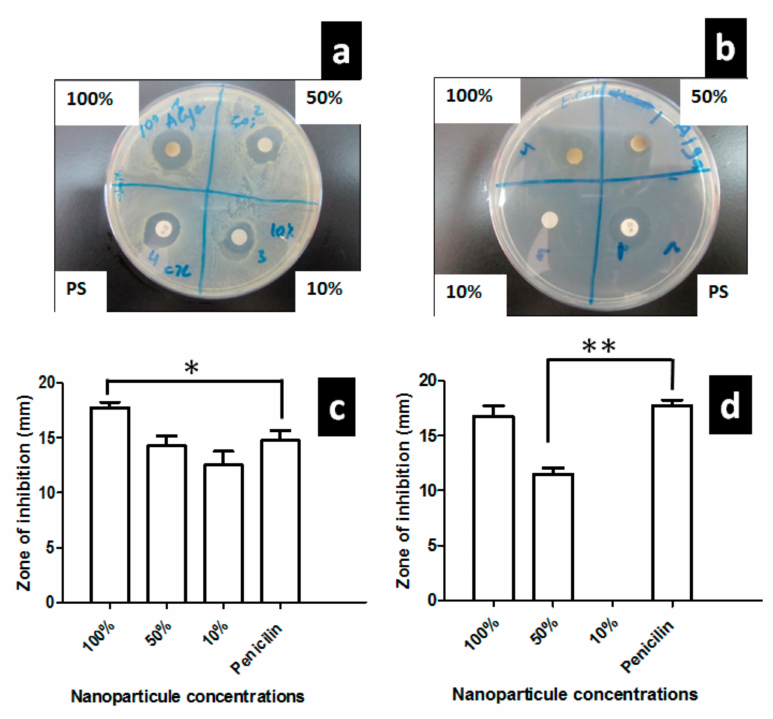
Figure 6. Bacterial growth inhibition using 100%, 50%, and 10% v / v Algae-AgNPs on Staphylococcus aureus ( a ), and Escherichia coli ( b ), the average and standard deviation of four replicates of inhibition circles around the inhibited zone of Staphylococcus aureus and Escherichia coli respectively ( c , d ). * p ≤ 0.05 and, ** p ≤